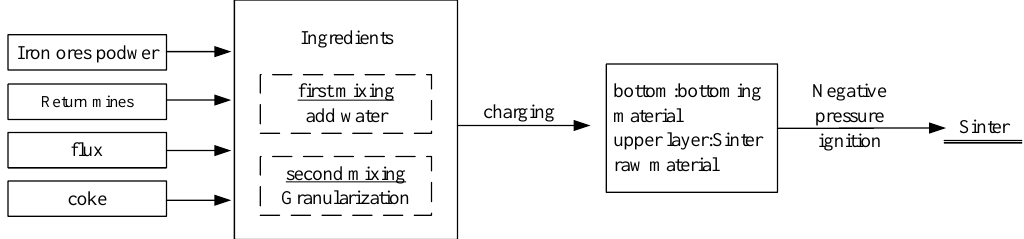
Figure 11. Schematic diagram of sintering pot test process.